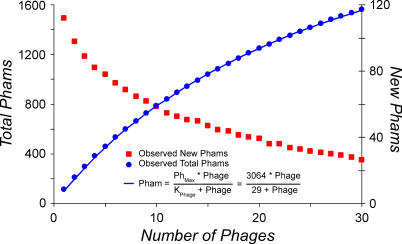
Estimating the Number of Mycobacteriophage PhamsA subset of the 30 phages was randomly selected without replacement, and the total number of Phams was determined; this was repeated 10,000 times with the mean shown as a blue circle. For each subset, an additional phage was then randomly chosen, and the average number of new Phams found in that phage was determined; these data are shown as red squares. The total number of Phams was fit to a hyperbolic function, with the best-fit equation determined by least-squares regression.